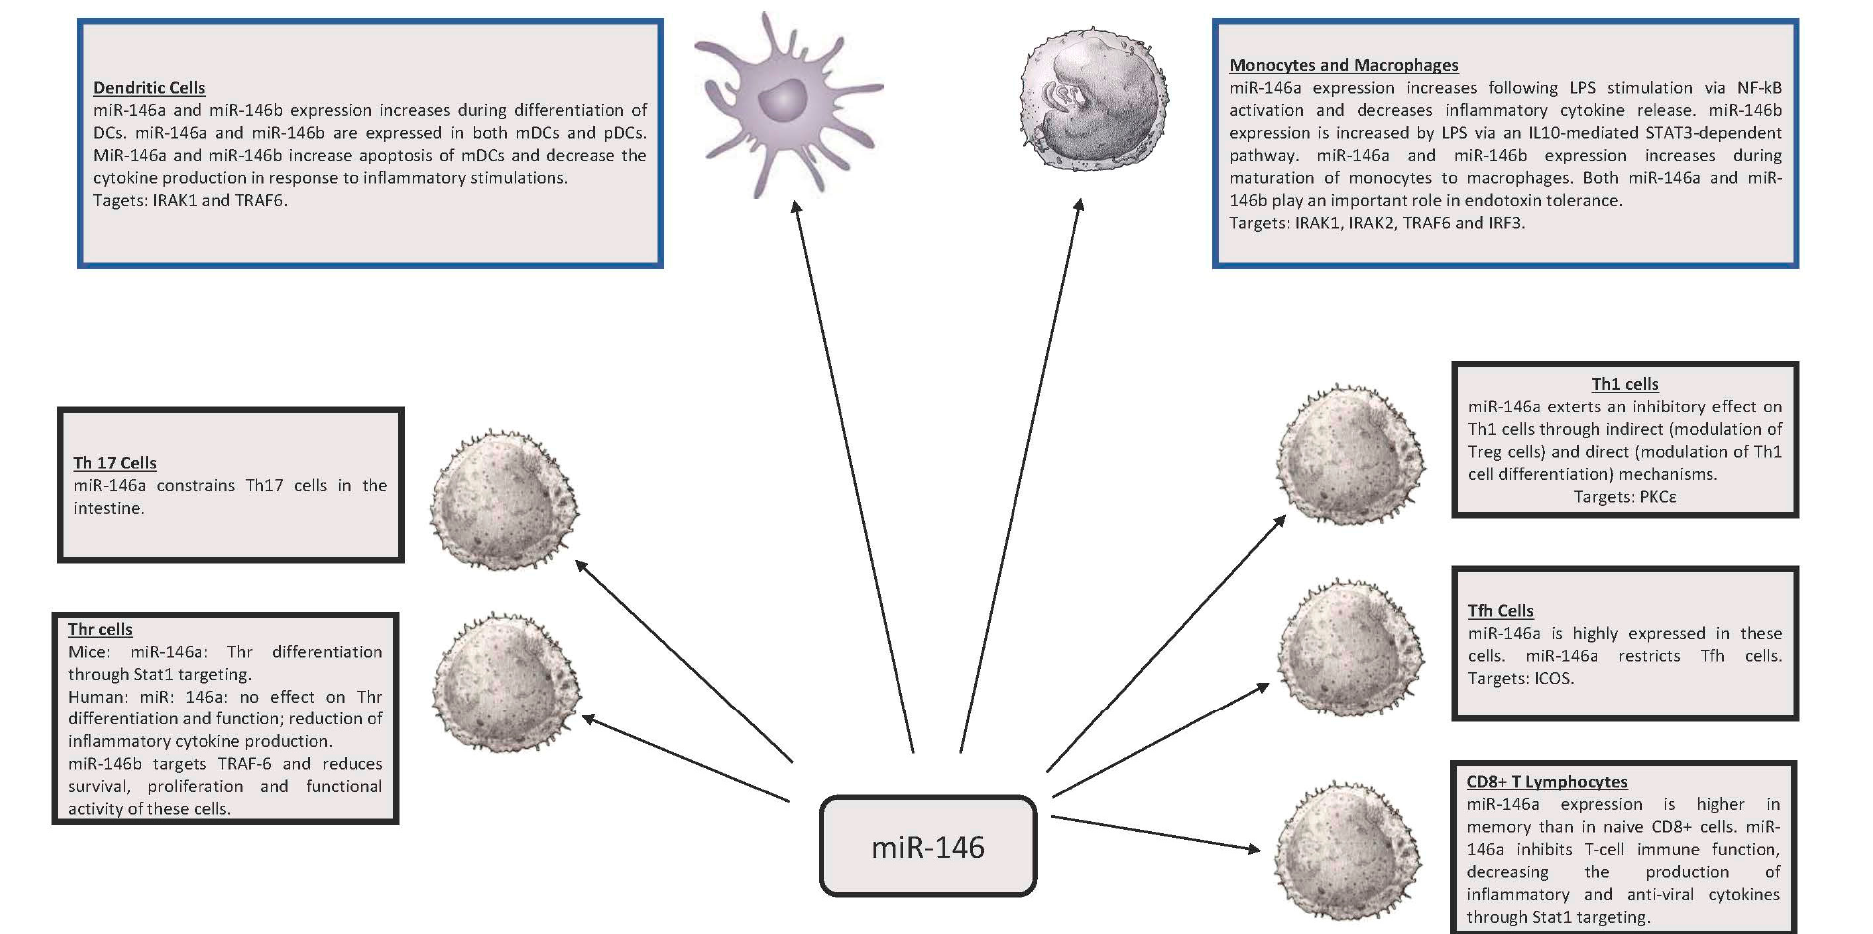
Figure 1. Expression and function of miR-146 in various cell types of the immune system. mDC: myeloid Dendritic Cell. pDC: plasmocytoid Dendritic Cell. LPS: